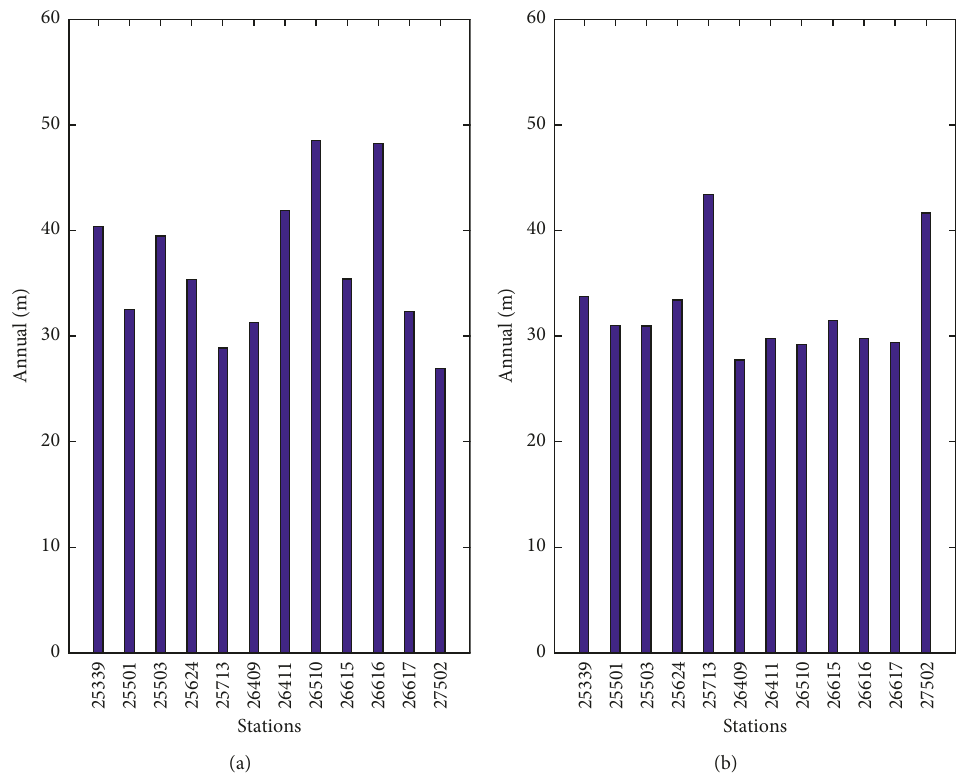
Figure 5: Annual average thickness (m) distribution of atmospheric (a) surface ducts and (b) elevation ducts at 12 stations in Alaska.